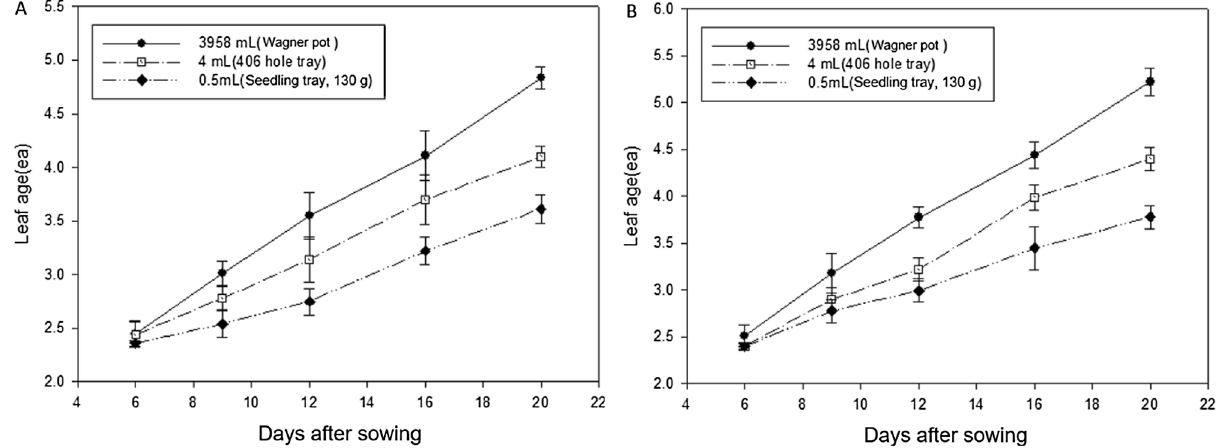
Figure 8. Changes in rice leaf development for 20 days after sowing in response to root growth space. ( A ) Odae, ( B ) Saenuri. Error bars are standard